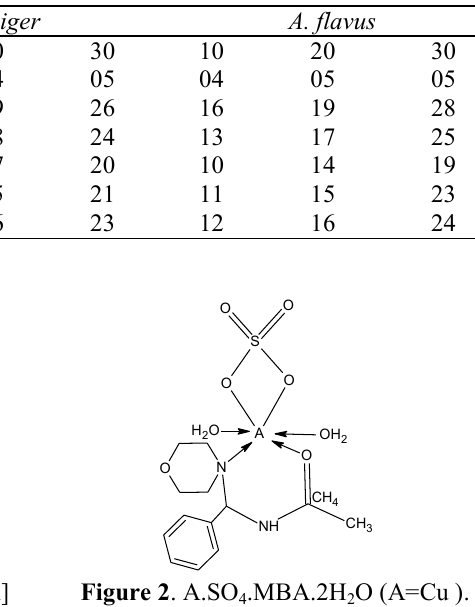
Table 4. Antifungal Activity of Ligand and its Complexes.